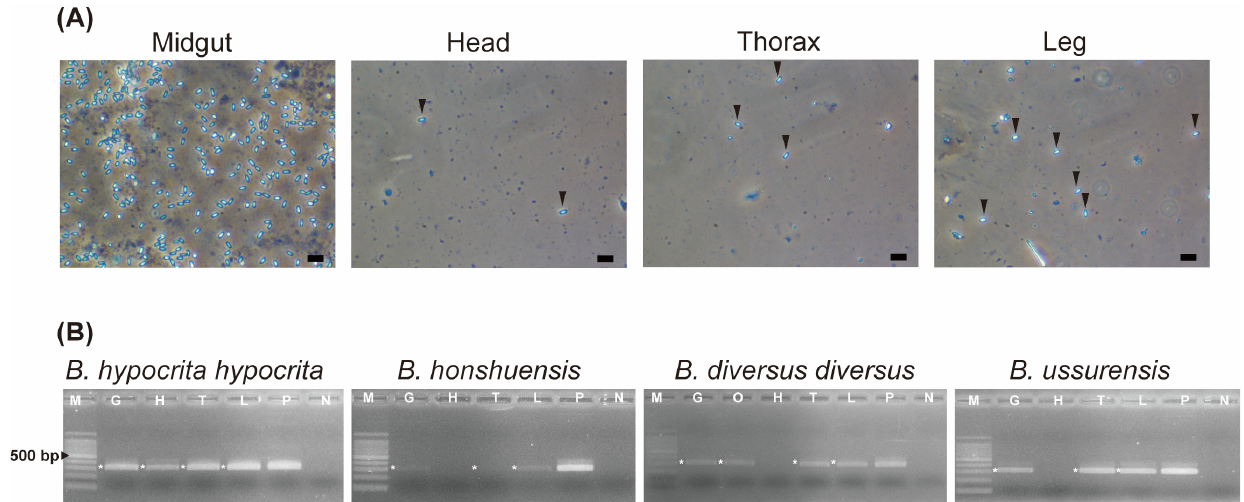
Figure 3. Organ specificity of Vairimorpha spp. ( A ) Images of the Vairimorpha spp.-infected organs of B. hypocrita hypocrita under a phase-contrast microscope ( × 400): midgut, head, thorax, and leg. Arrowheads indicate microsporidian spores. Scale bar = 10 µ m. ( B ) PCR detection of